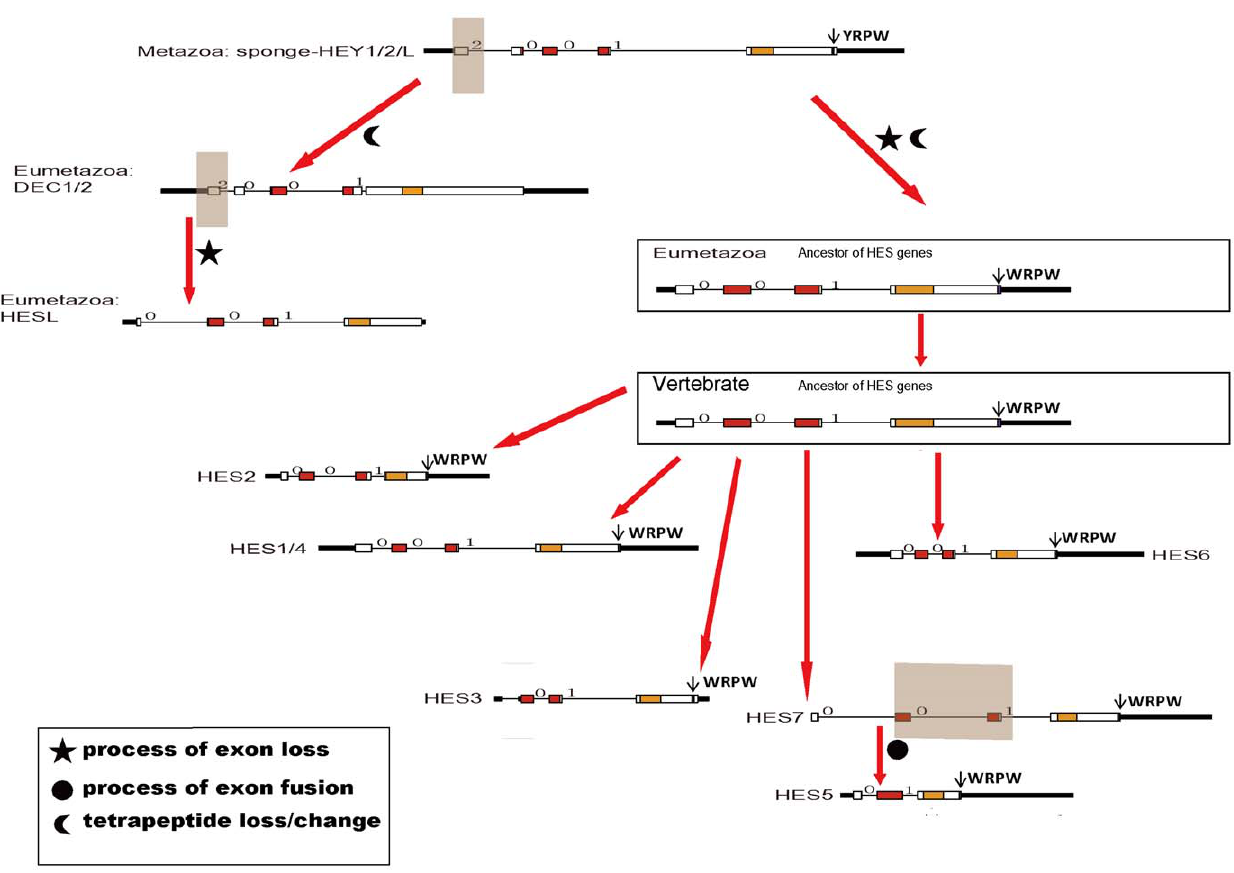
Figure 7. A model for the evolutionary process of the HES/HEY gene family. Filled boxes of the gene exon-intron structure: red represent bHLH domain, orange represent Orange domain, purple represent WRPW motif, blue represent YXXW motif; white boxes: other exon regions; lines: introns. Numbers 0, 1, and 2: exon phases. The length of the boxes and lines are scaled based on the length of genes. The transparent faint red boxes above exons or introns indicate the fused exons or lost exons.